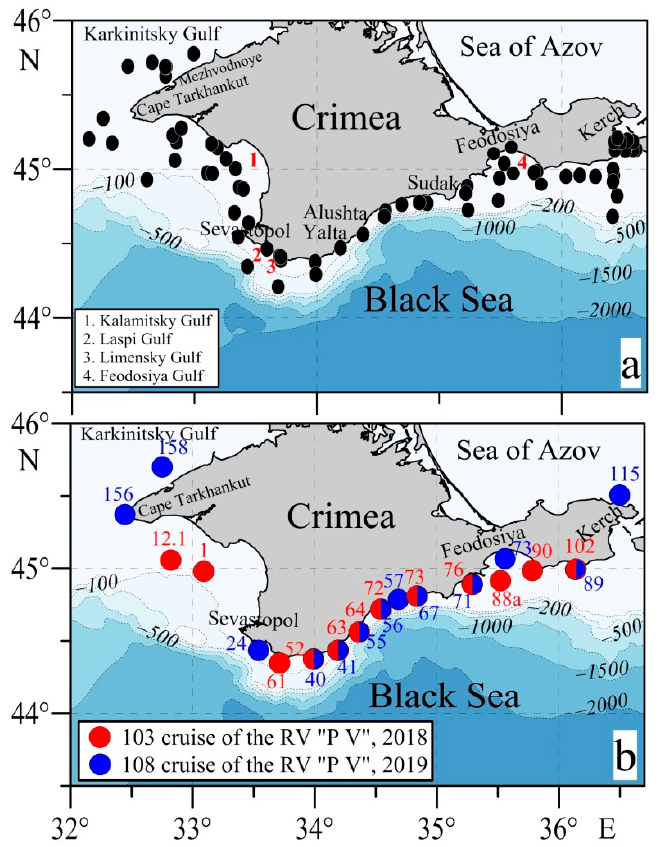
Figure 1. Scheme of sampling stations ( a ) bottom sediments surface layer and bottom water layer; ( b ) columns of bottom sediments. Samples from the bottom waters were taken for chemical analysis using bathome- ters.